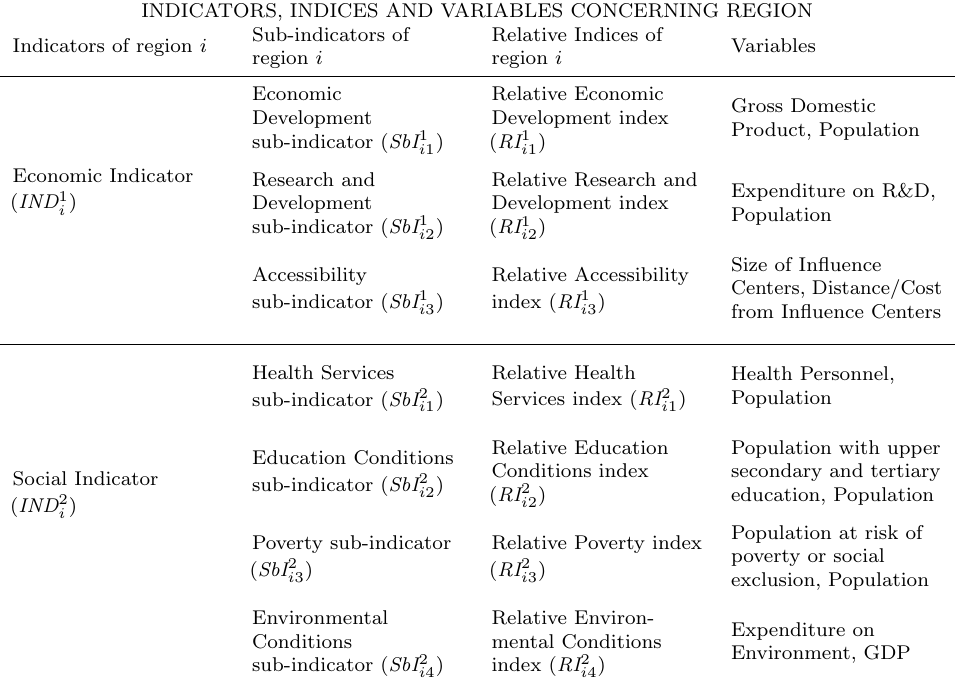
Table 3: Variables affecting region’s i development and their conversion into its Economic and Social